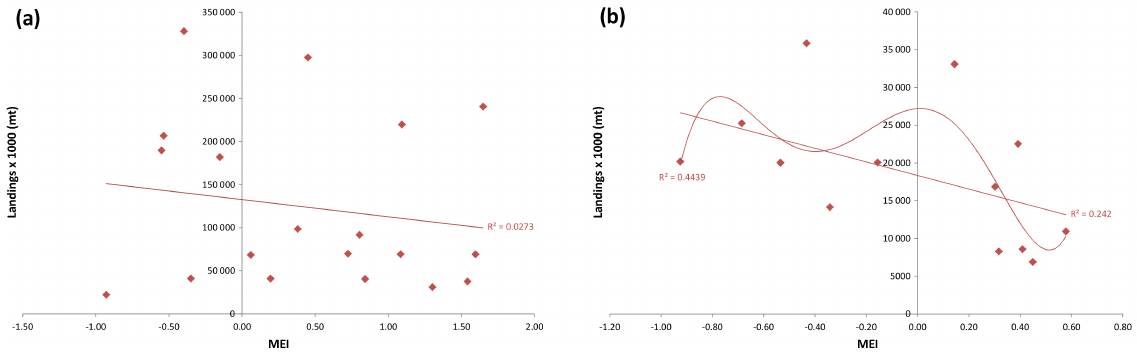
Figure 13. Correlation of pinchagua landings and MEI in the periods (a) 1981–1999 and (b) 2000–2012. Polynomial ( n = 5).